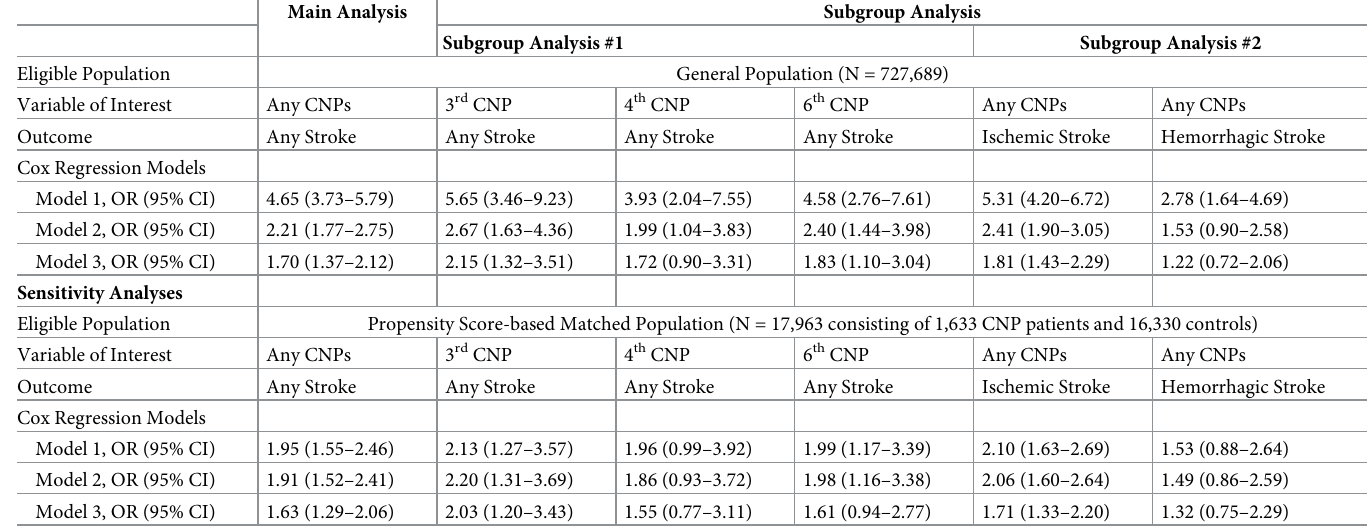
Table 3. Results of time-varying cox regression models for the main analyses and subgroup analyses in both the eligible population and propensity score-based matched